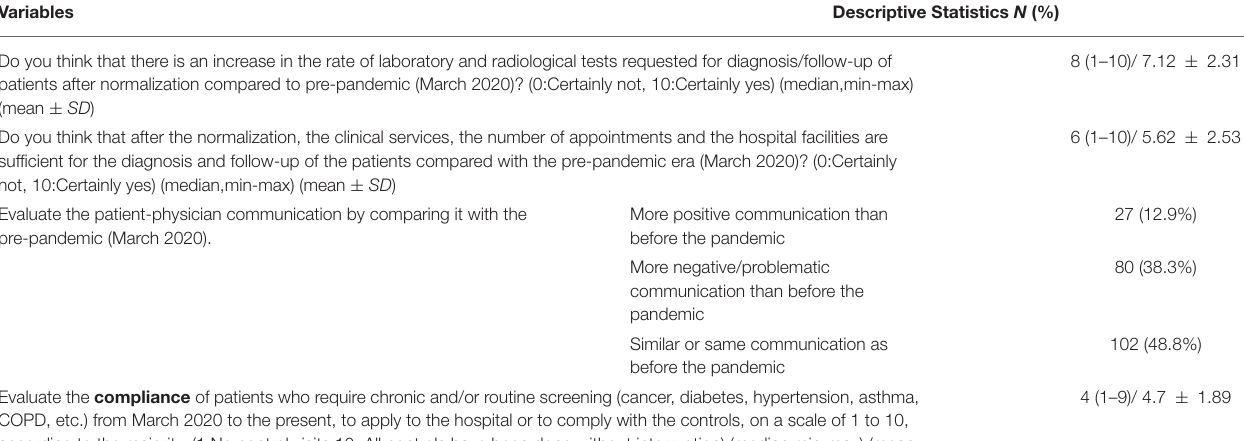
TABLE 4 | Impact of the COVID-19 pandemic on clinical services and healthcare, and COVID-19-related feelings and thoughts. Variables Descriptive Statistics N